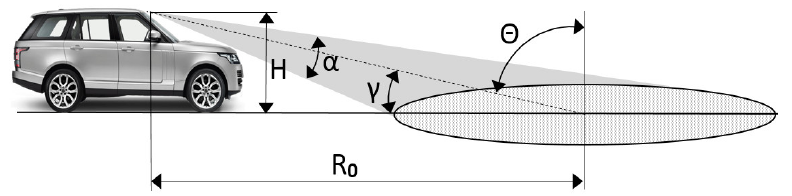
Figure 3. Automotive sensing scenario: H —Radar height over ground, α —Elevation beam width, R 0 —Ground range, θ —Incident angle, γ —Grazing angle.